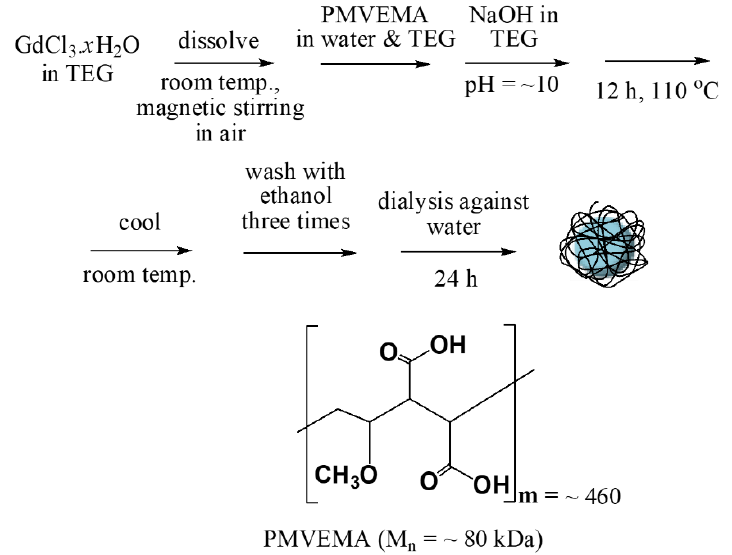
Figure 8. Reaction scheme for the one-pot polyol synthesis of PMVEMA-coated ultra-small Gd 2 O 3 NPs and the molecular structure of PMVEMA.